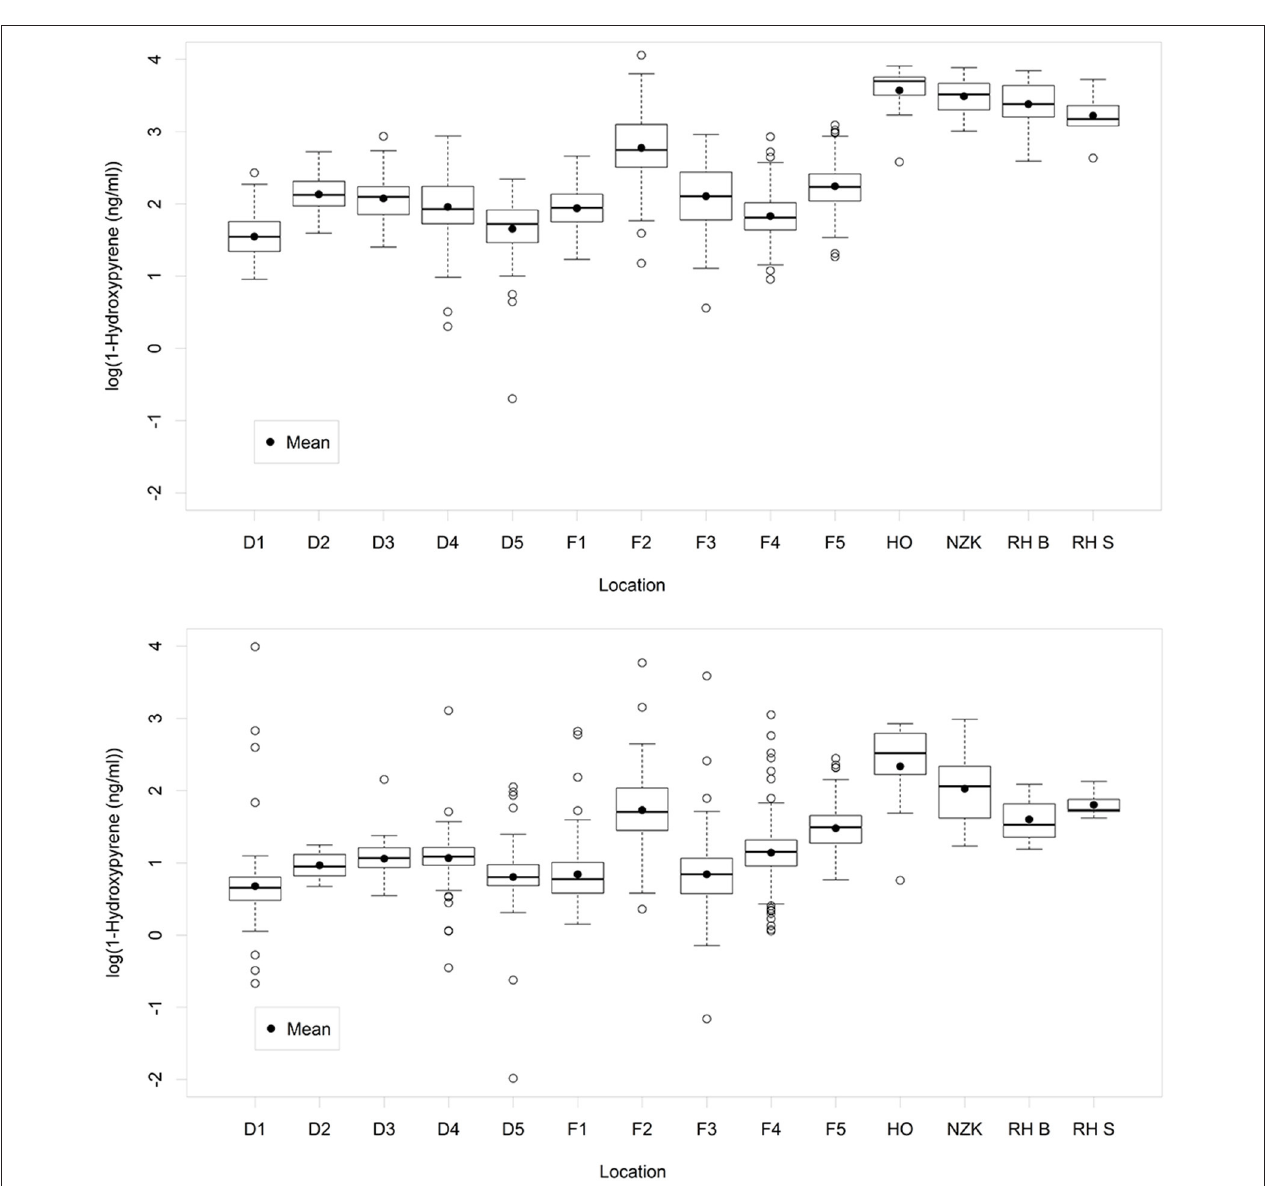
FIGURE 2 | Boxplots of the variation of 1-OH-pyrene (log transformed concentration) per sampling location: Upper graph: original data. Lower graph: standardized data. A box represents the IQR-range between the 25th and the 75th percentile, with the median as a line in the box. The vertical lines represent data within the ± 1.58 IQR/sqrt(n), where n = number of data. Open circles outside the range of the whiskers represent individual